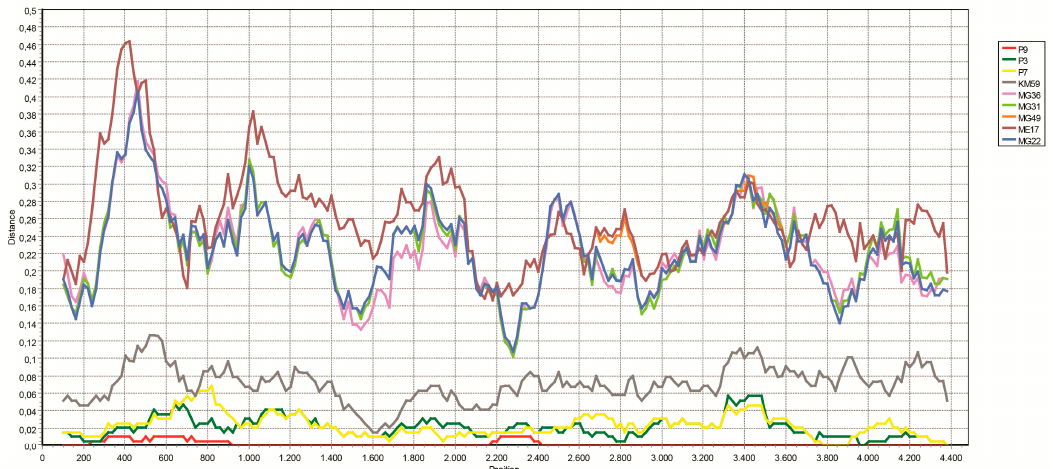
Figure 3. Plots of similarity of the near-complete polymerase coding alignment (4480 bp) of tick phlebovirus Anatolia 1 isolate KM2 (MG764521) with closely-related strains (GapStrip: On, Reps: 1000, Maximum Likelihood, T / t: 2.0). The curves indicate comparisons between the target and reference genomes (P9: MN069029, P3: MN069028, P7: MN069030, KM59: MG764522, MG36: KY979167, MG31: KY979166, MG49: KY979168, ME17: MG764523, MG22: KY979165). Each point plotted is the percent identity within a sliding window 200 bp, wide centered on the position plotted, with a step size between points of 20 bp.